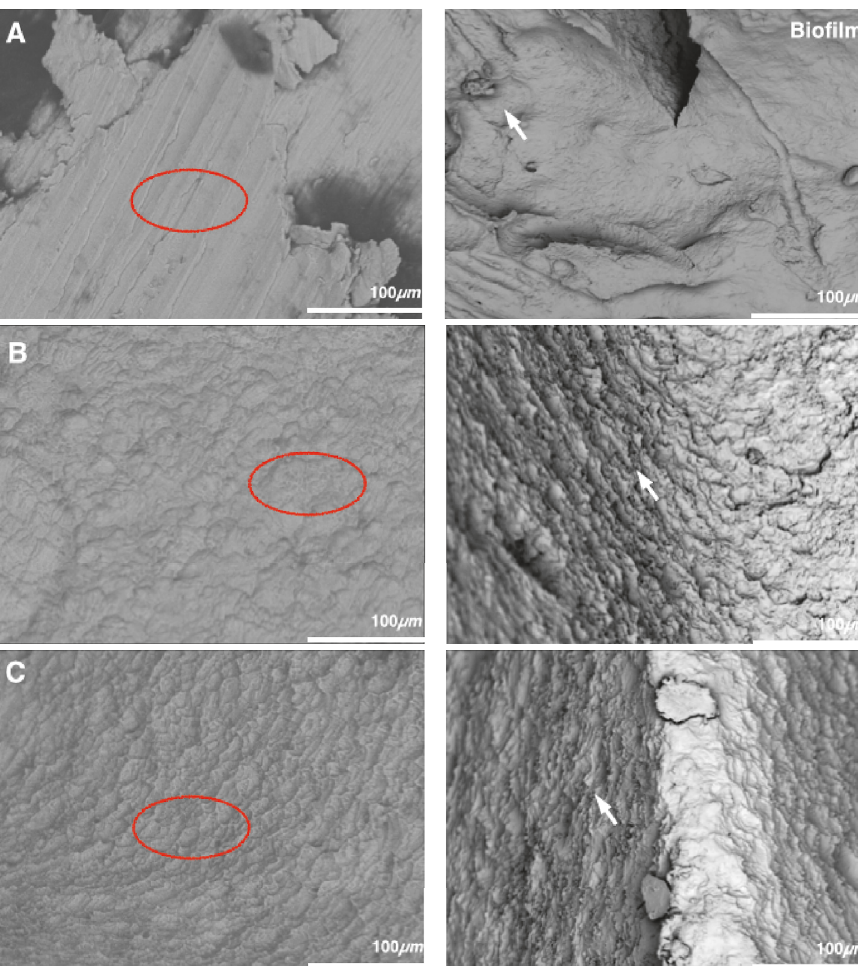
Figure 3: Scanning electron microscopy (SEM) images of the titanium surface displaying topography features before and after the S. mutans biofilm formation ((A) implantoplasty, (B) acid treatment, and (C) debridement) (Magnification D8.6 × 1.0k 100 𝜇 m).